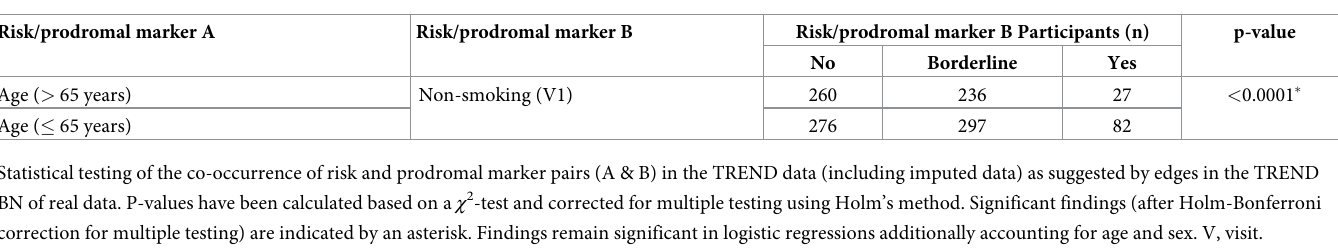
age and the risk and prodromal markers of PD. Table 4 shows five arbitrary examples of syn- thetic subjects (from the synthetic cohort with the same sample size) and three real subjects together with their individual data (at visit 4) on age, sex, MDS-UPDRS-III, pRBD, depression, global cognitive deficits and PD conversion status. The Multiple Correspondence Analysis (MCA) [21] plot shown in Fig 2 indicates the similarity of synthetic subjects in relation to real ones. Further systematic comparisons of the distribution of individual variables and their cor- relation structure are presented in the (S2-S6 Figs in S1 Appendix). An RF classifier trained to discriminate between real and synthetic subjects only performed slightly better than chance level (pAUC 52%), indicating that both real and synthetic subjects cannot be reliably discrimi- nated (S8 Fig in S1 Appendix).